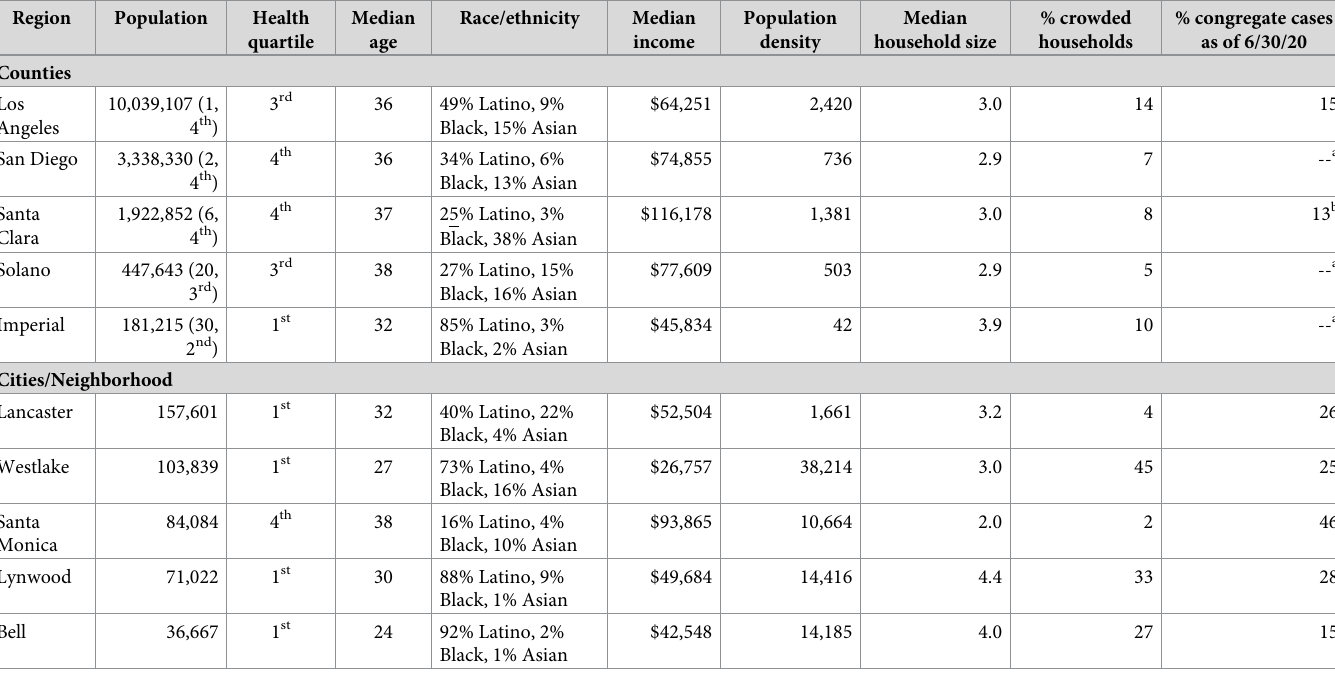
Table 1. Characteristics of selected California counties and neighborhood/cities within Los Angeles